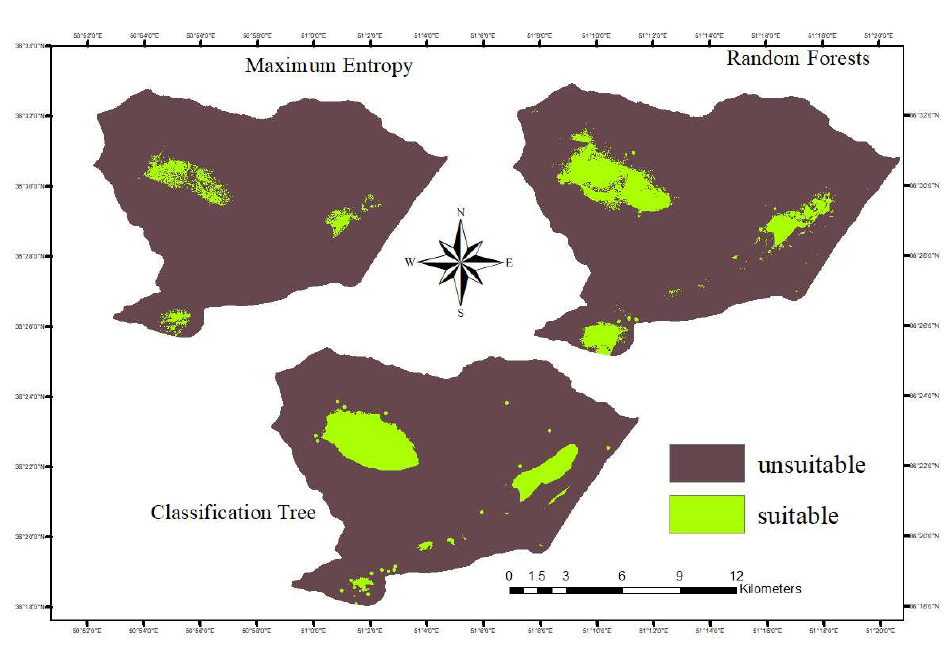
F IGURE 5. Binary maps of suitable area resulted by each model in cold